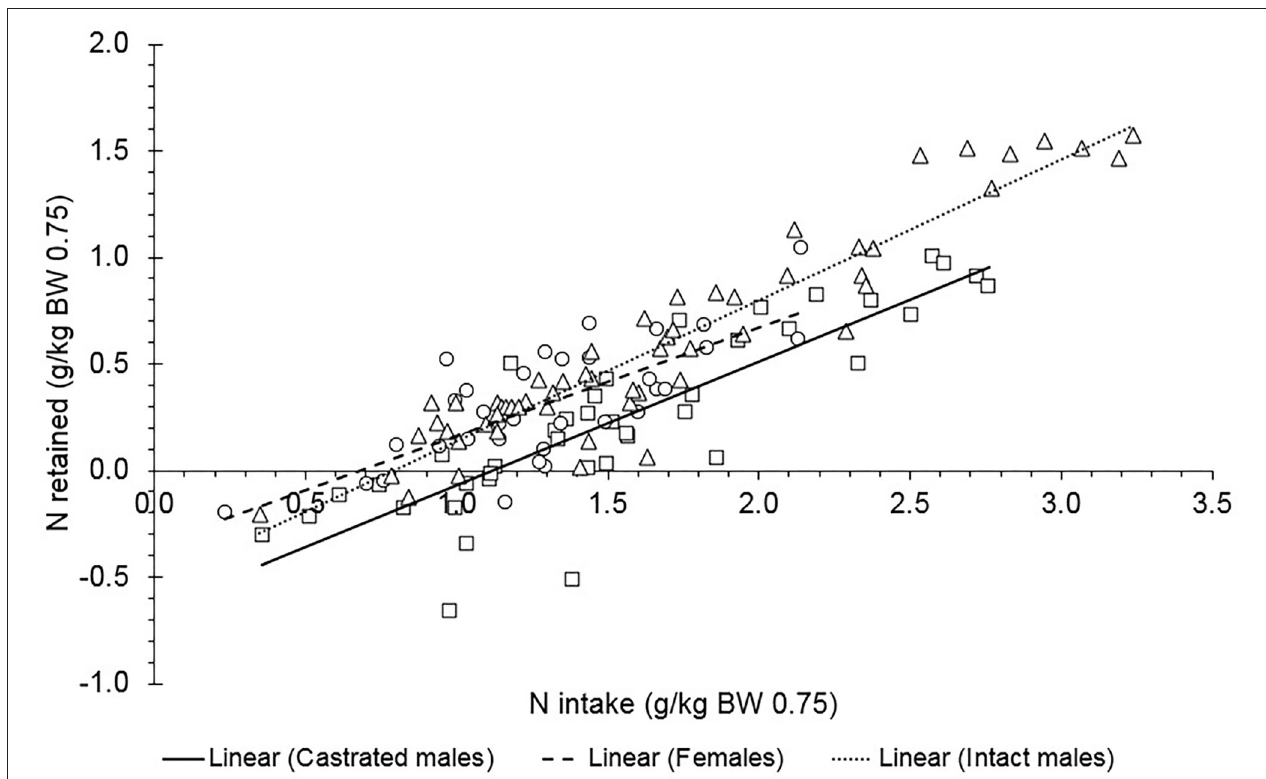
FIGURE 1 | Relationship between daily N retained (g/kg 0.75 BW) and daily N intake (g/kg 0.75 BW) of Saanen goats of different sexes using the comparative slaughter technique. For all animals: N retained = − 0.197 ( ± 0.0300) + 0.292 ( ± 0.0179) × N intake. The estimated block nested to study variances ( σ 2 b : s ) and the residual variances ( σ 2 e ) were 0.0109 and 0.00655, respectively. The parameters of the equation did not differ between sexes ( P = 0.67). The observations were adjusted for the study effect.